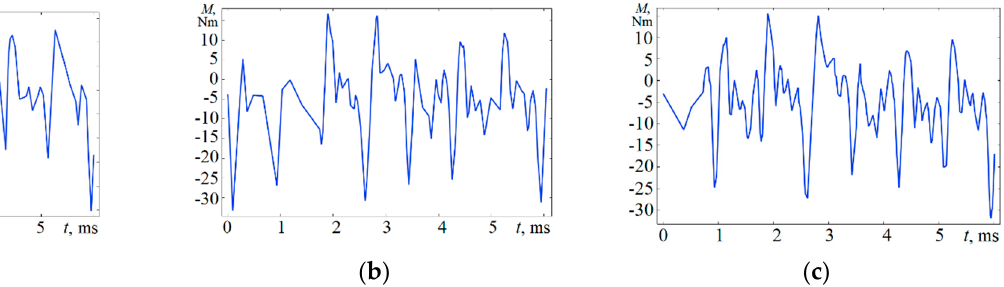
Figure 6. Electromagnetic torque of the investigated motor with harmonic distortion of the supply voltage: ( a ) I g 3 = I g 5 = 0 A ; ( b ) I g 3 = 8.8 A , I g 5 = 3.3 A ; ( c ) I g 3 = 15.4 A , I g 5 = 7.7 A . voltage: ( a ) I g 3 = I g 5 = 0 A ; ( b ) I g 3 = 8.8 A, I g 5 = 3.3 A ; ( c ) I g 3 = 15.4 A, I g 5 = 7.7